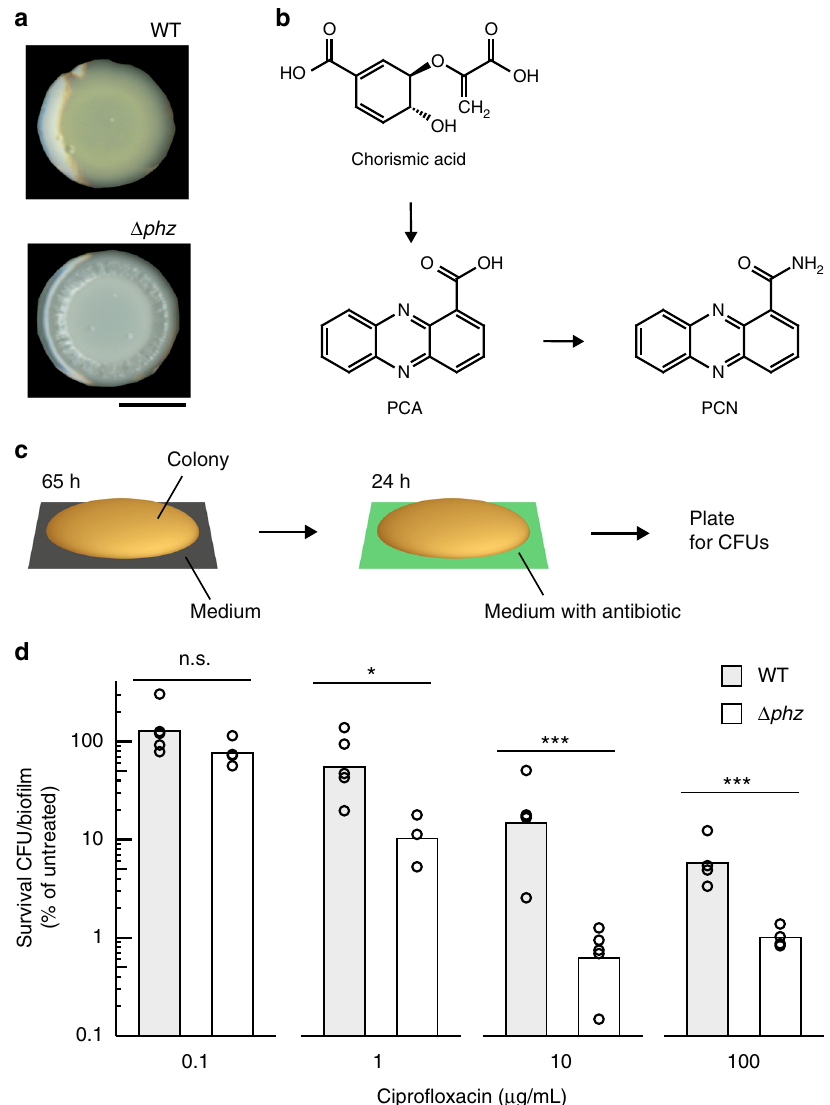
Fig. 1 Cells from phenazine-null bio fi lms show increased sensitivity to cipro fl oxacin. a Four-day-old colony bio fi lms of PA14 WT and the phenazine-null mutant ( Δ phz ) grown on a de fi ned medium containing 20 mM glucose. Scale bar is 5 mm. b Schematic representing the biosynthesis of